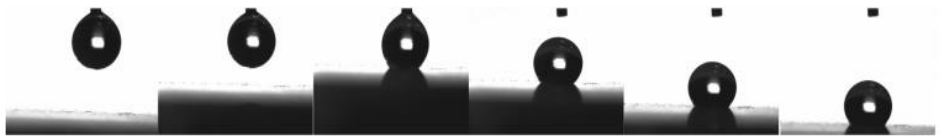
Figure 27. Measurement process of droplet WCA operation (Reprinted with permission from Ref. [69]. 2019, Yang, C.J.).